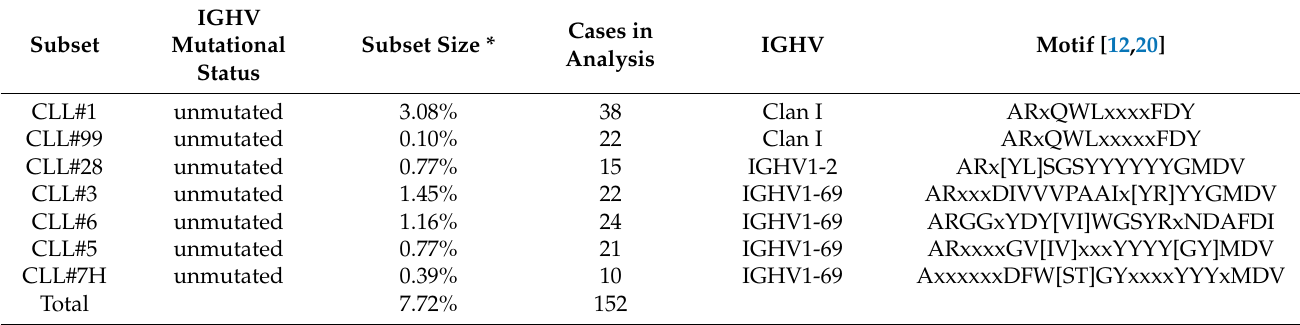
Table 1. SAR subgroups included in the